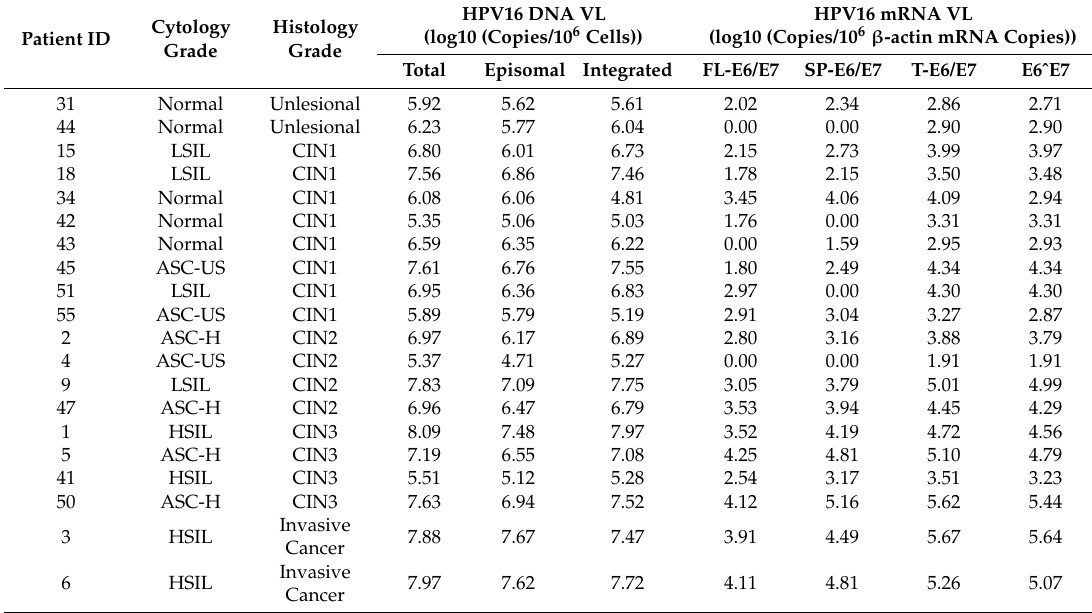
Table 4. Quantification of HPV16 DNA and E6/E7 mRNA VLs in uterine cervical smears (UCS). Patient